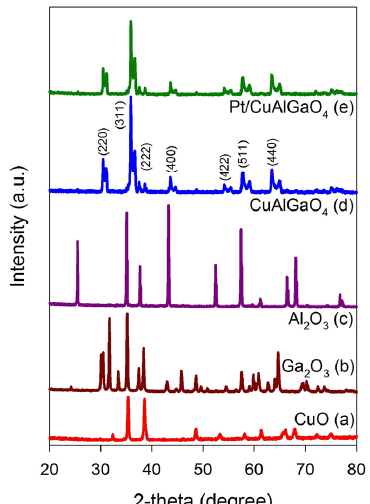
Figure 2. X ‐ ray diffraction (XRD) patterns of photocatalysts: CuAlGaO 4 and 1 wt % Pt/CuAlGaO 4 , in compared with starting materials of CuO, Al 2 O 3 , and Ga 2 O 3 .